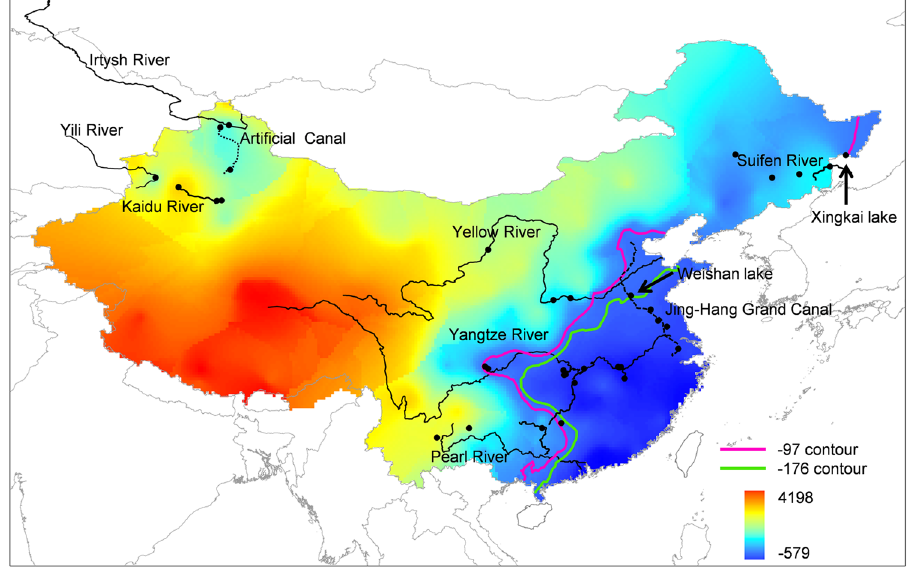
Figure 3. A predicted map of hexaploid frequency distribution throughout mainland China by using hexaploid group indexes. As hexaploid group indexes were of significantly difference (p = 0, < 0.05) among three assigned hexaploid frequency groups, the lowest value of all-hexaploid frequency group at Xingkai lake ( − 97) and the highest value of high frequency (51–99%) hexaploid group at Weishan lake ( − 176) were respectively used as critical values of all-hexaploid group and high frequency (51–99%) hexaploid group through discriminant analysis. The purple − 97 contour line stands for the predicted boundary between all-hexaploids and high frequency (51–99%) hexaploids. The green − 176 contour line represents the predicted boundary between high frequency (51–99%) hexaploids and low frequency (0–50%) hexaploids. − 579 and 4198 indicate the lowest and highest values of predicted hexaploid group indexes respectively. The map was created in ARCMAPv.9.3 (ESRI, Redlands, CA, USA)